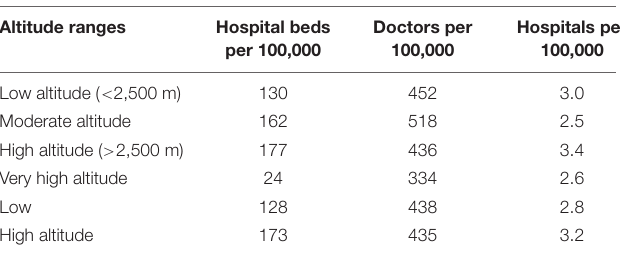
TABLE 4 | Number of hospital’s beds, number of doctors, and number of hospitals per 100,000 people living in Ecuador by different elevation range. Altitude